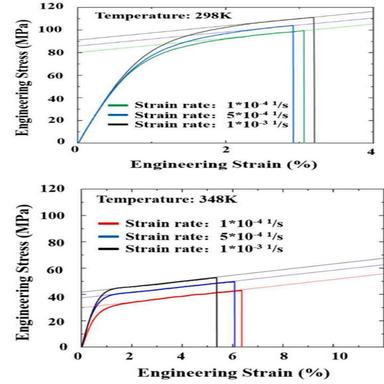
Comparison between predicted saturation stress values and actual values before correction.